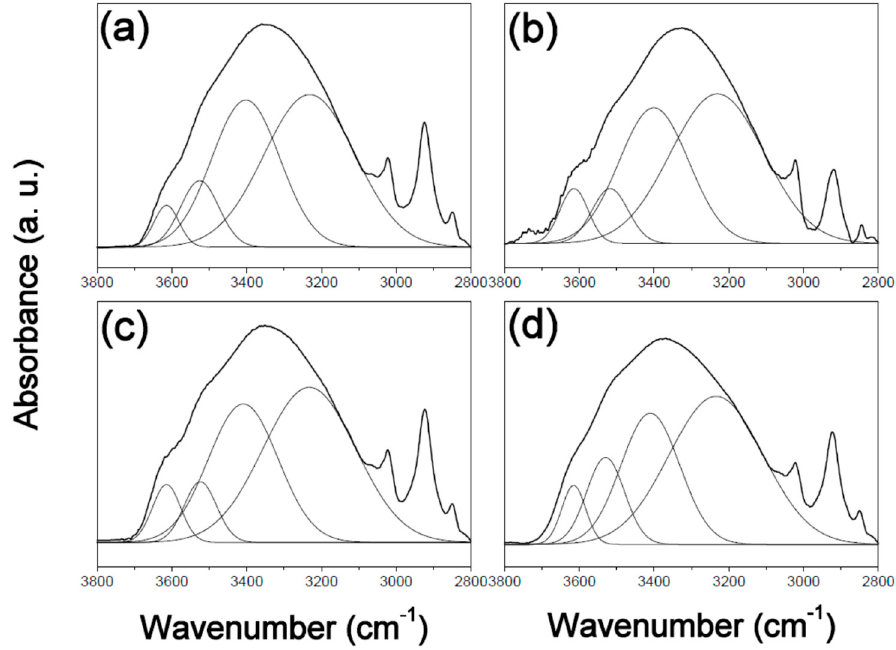
Figure 2. FT-IR spectra of poly(vinyl phenol) prepared in propylene glycol methyl ether acetate (PVPh-P) thermally treated at 180 °C for ( a ) 0, ( b ) 1, ( c ) 4, and ( d ) 8h, overlaid with Gaussian-fitted curves.